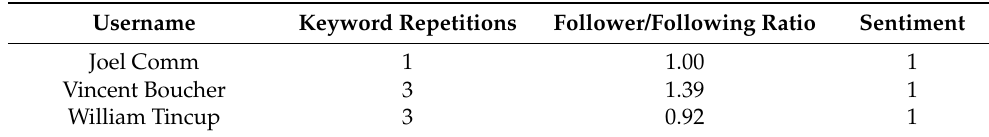
Table 5. Mood Research Results with RST decomposition method